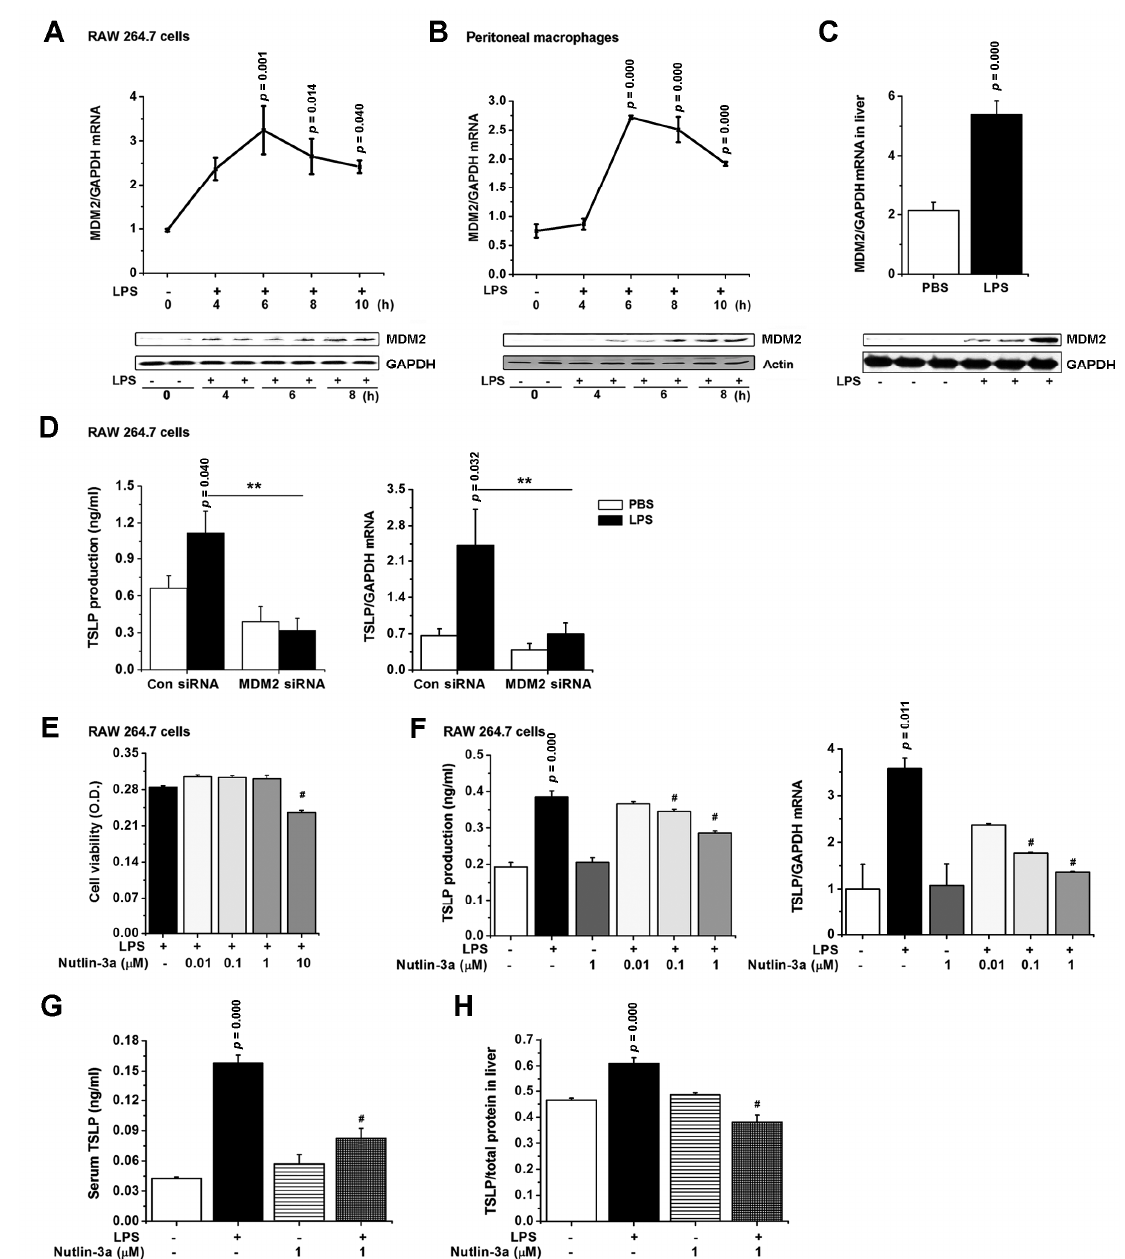
Figure 4. TSLP is produced via MDM2 signaling in macrophages. ( A , B upper panel) The mRNA and ( A , B lower panel) protein expressions of MDM2 were analyzed by real-time PCR and Western blot. ( C , upper panel) The mRNA and ( C , lower panel) protein expressions of MDM2 in liver were analyzed by real-time PCR and Western blot. ( D , left) The production of TSLP 24 h and ( D , right) mRNA expression of TSLP 8 h after LPS stimulation were analyzed in RAW 264.7 cells by ELISA and real-time PCR. ** p < 0.05 vs. Con siRNA transfection and LPS stimulation. ( E ) Cell viability was analyzed by an MTT assay. RAW 264.7 cells were treated with nutlin-3a for 2 h and stimulated with LPS ( F , left) for 24 h for ELISA and ( F , right) 8 h for real-time PCR. Data are representative of three independent experiments ( n = 5 / group). # p < 0.05 vs. LPS stimulation. ( G ) Serum at 4 h and ( H ) liver homogenate at 12 h following LPS injection from nutlin-3a-treated septic mice were subjected to ELISA ( n = 10 / group). Adducts were normalized to total protein in liver homogenate. 0.001% DMSO was treated as a vehicle negative control for nutlin-3a in LPS-unstimulated group. A p value indicates the significant difference between PBS and LPS. # p < 0.05 vs. LPS-injected mice. PBS, phosphate-buffered saline; LPS, lipopolysaccharide; TSLP, thymic stromal lymphopoietin; Con, control; siRNA, small interfering RNA; MDM2, murine double minute 2.